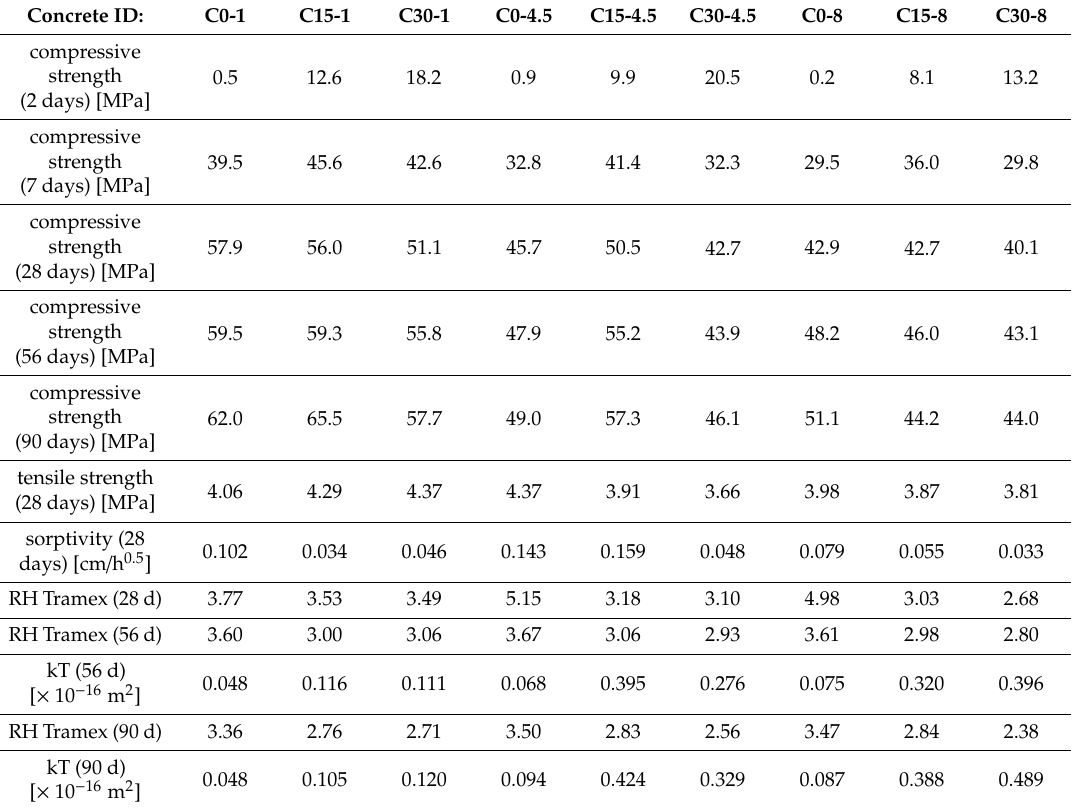
Table 5. Results of tests of strength and durability